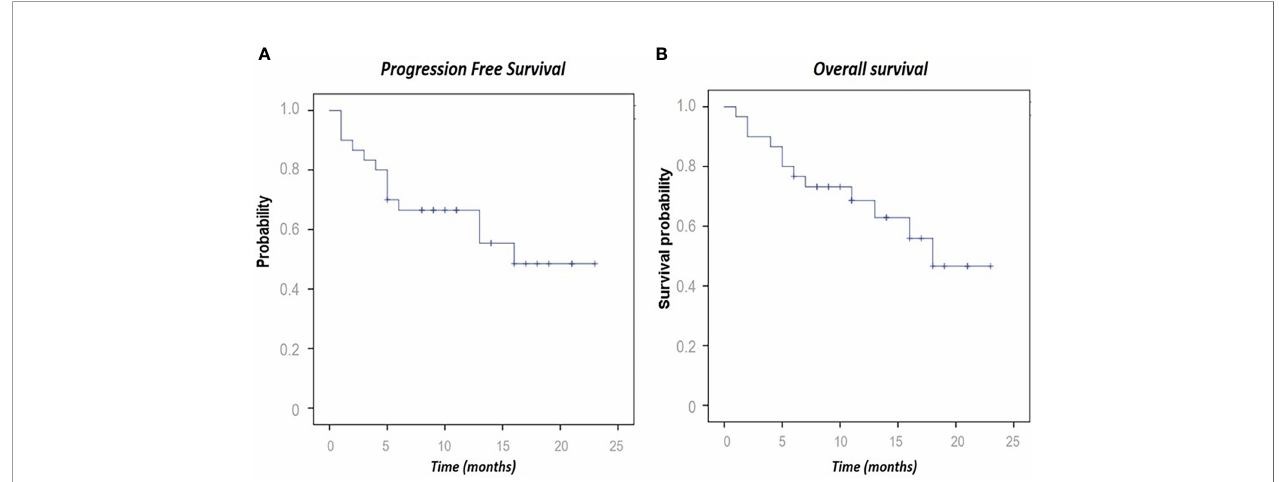
FIGURE 4 | Kaplan – Meier curves for progression-free survival (A) and overall survival (B)